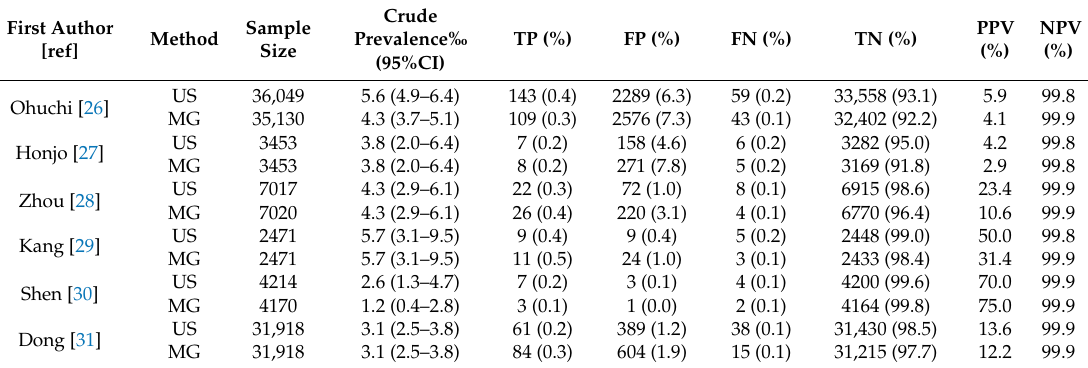
Table 2. Diagnostic accuracy of mammography and ultrasound in the included studies.